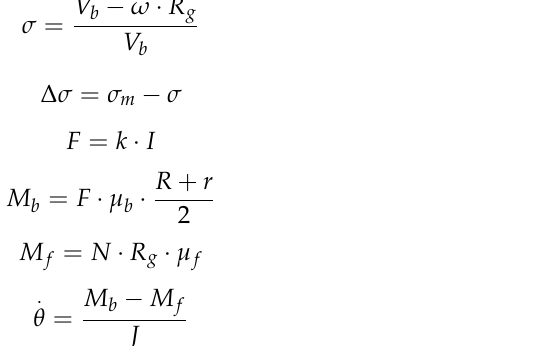
Table 1. Simulation parameters.